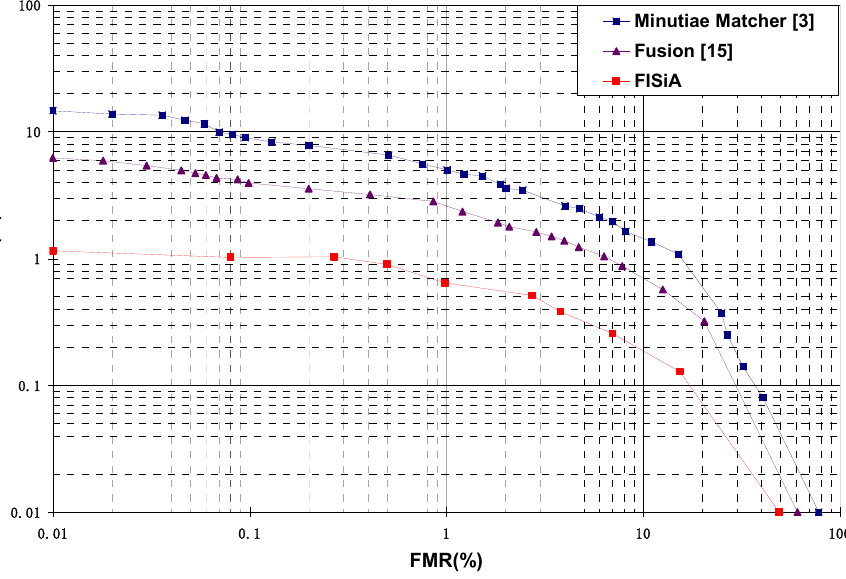
Figure 11. Comparison on a specific database, DB_cuts.